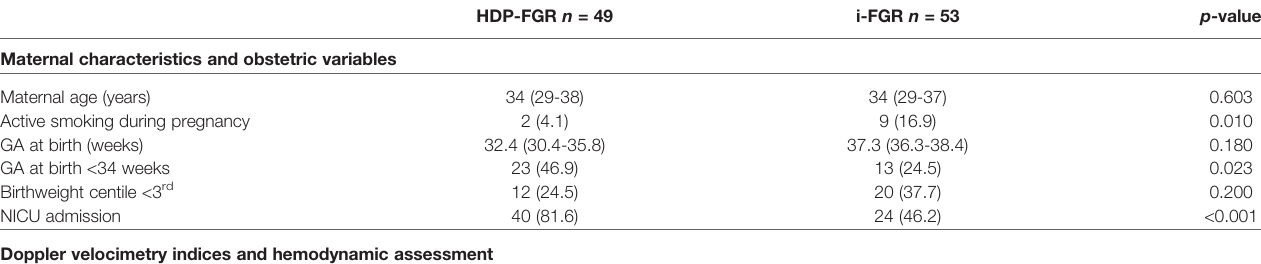
TABLE 5 | Demographic, obstetric, and hemodynamic data of HDP-FGR and i-FGR.